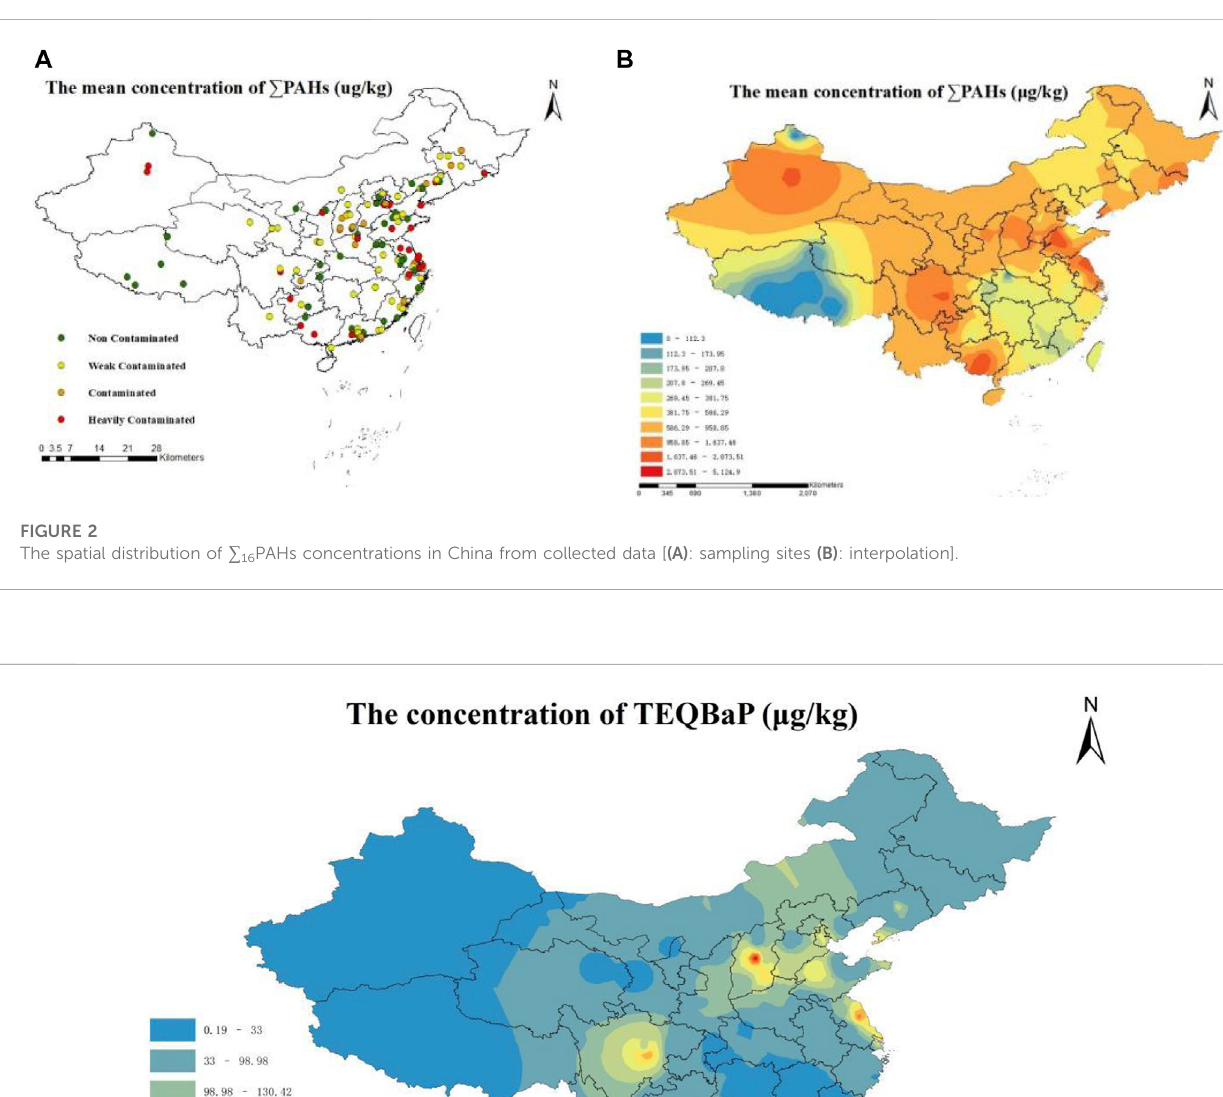
different regions. The median values of (cid:1) 16 PAHs concentration in different regions ranked as: North China (Tianjin, Beijing, Hebei,